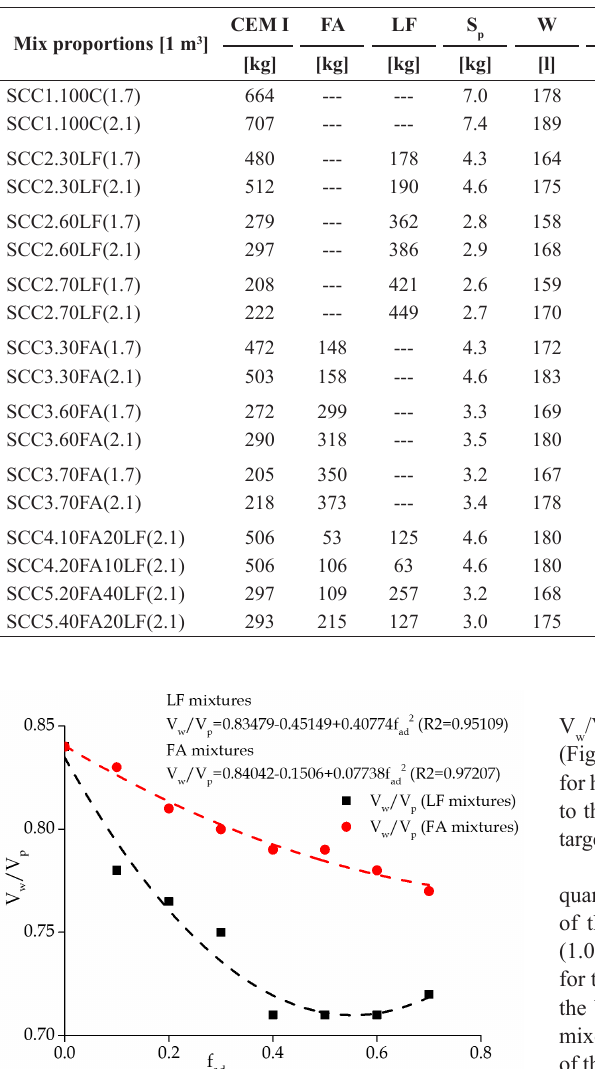
Table 4. Mix proportions of SCCs. Mix proportions [1 m 3 ]